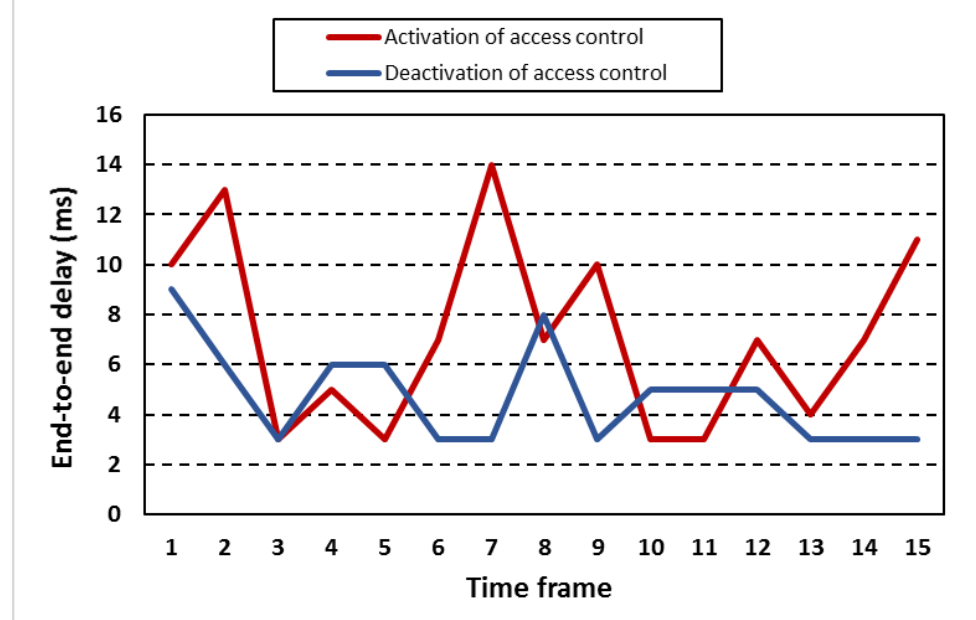
Figure 17. Average end-to-end delay between IoT server and web